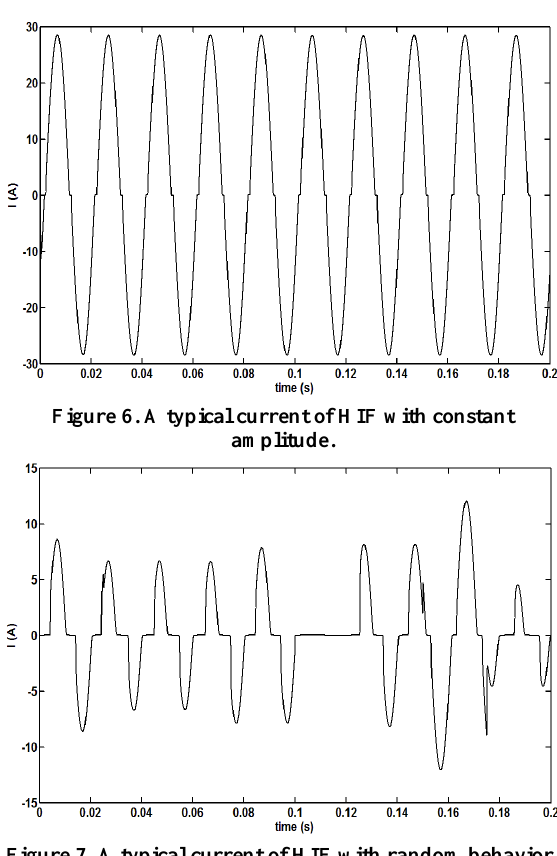
Figure 7. A typical current of HIF with random behavior.